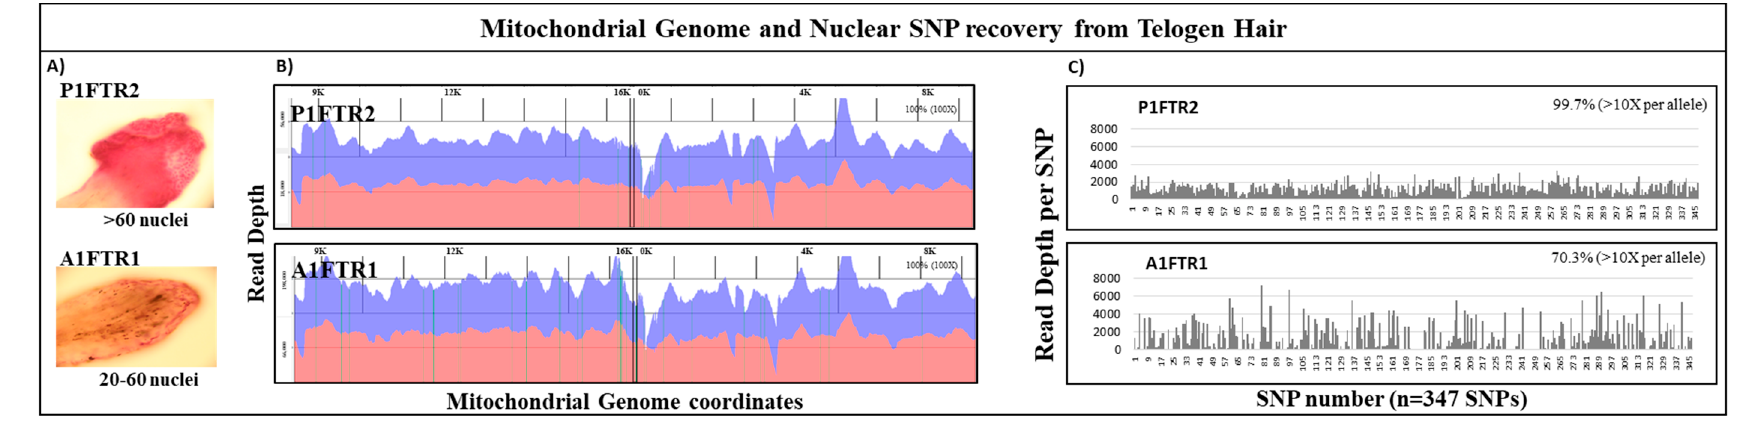
Figure 5. Recovery of mtDNA and nuclear SNPs from telogen hairs. ( A ) Microscopic images of stained telogen hair roots revealed that P1FTR2 exhibited >60 nuclei count while A1FTR1 exhibited 20–60 nuclei count. ( B ) mtgenome read depth plotted against mtgenome coverage coordinates was shown for P1FTR2 and A1FTR1. Blue coverage represents forward reads; red coverage represents reverse reads. Both P1FTR2 and A1FTR1 exhibited 100% coverage of the mtgenome at >100× read depth per base. ( C ) SNP coverage for P1FTR2 and A1FTR1 showed that P1FTR2 exhibited near 100% SNP coverage while A1FTR1 exhibited ~70% SNP coverage. Refer to Table S1 for details of the SNP numbers. Table 5. Sequencing statistics of mtDNA and nuclear SNPs recovery from telogen hairs.